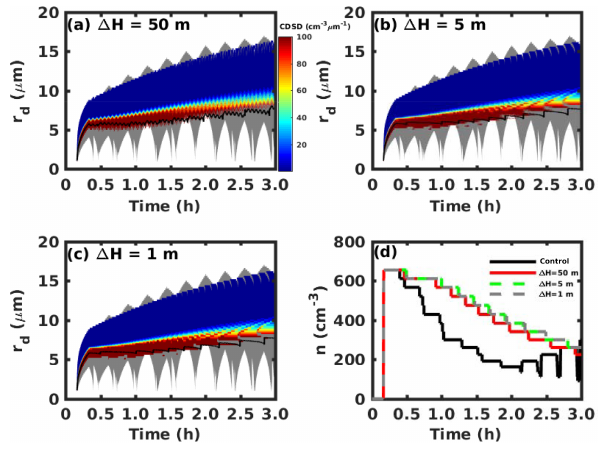
Figure 7. Cloud droplet size distribution (CDSD) changes with time for different thicknesses of recirculation layers: (a) (cid:49)H = 50m, (b) (cid:49)H = 5m and (c) (cid:49)H = 1m. (d) Total cloud droplet number concentration ( n ) changes with time for the different cases. The gray region in (a) – (c) represents the range of the droplet size spectrum for the control case, and the black lines represent the mean cloud droplet radius change with